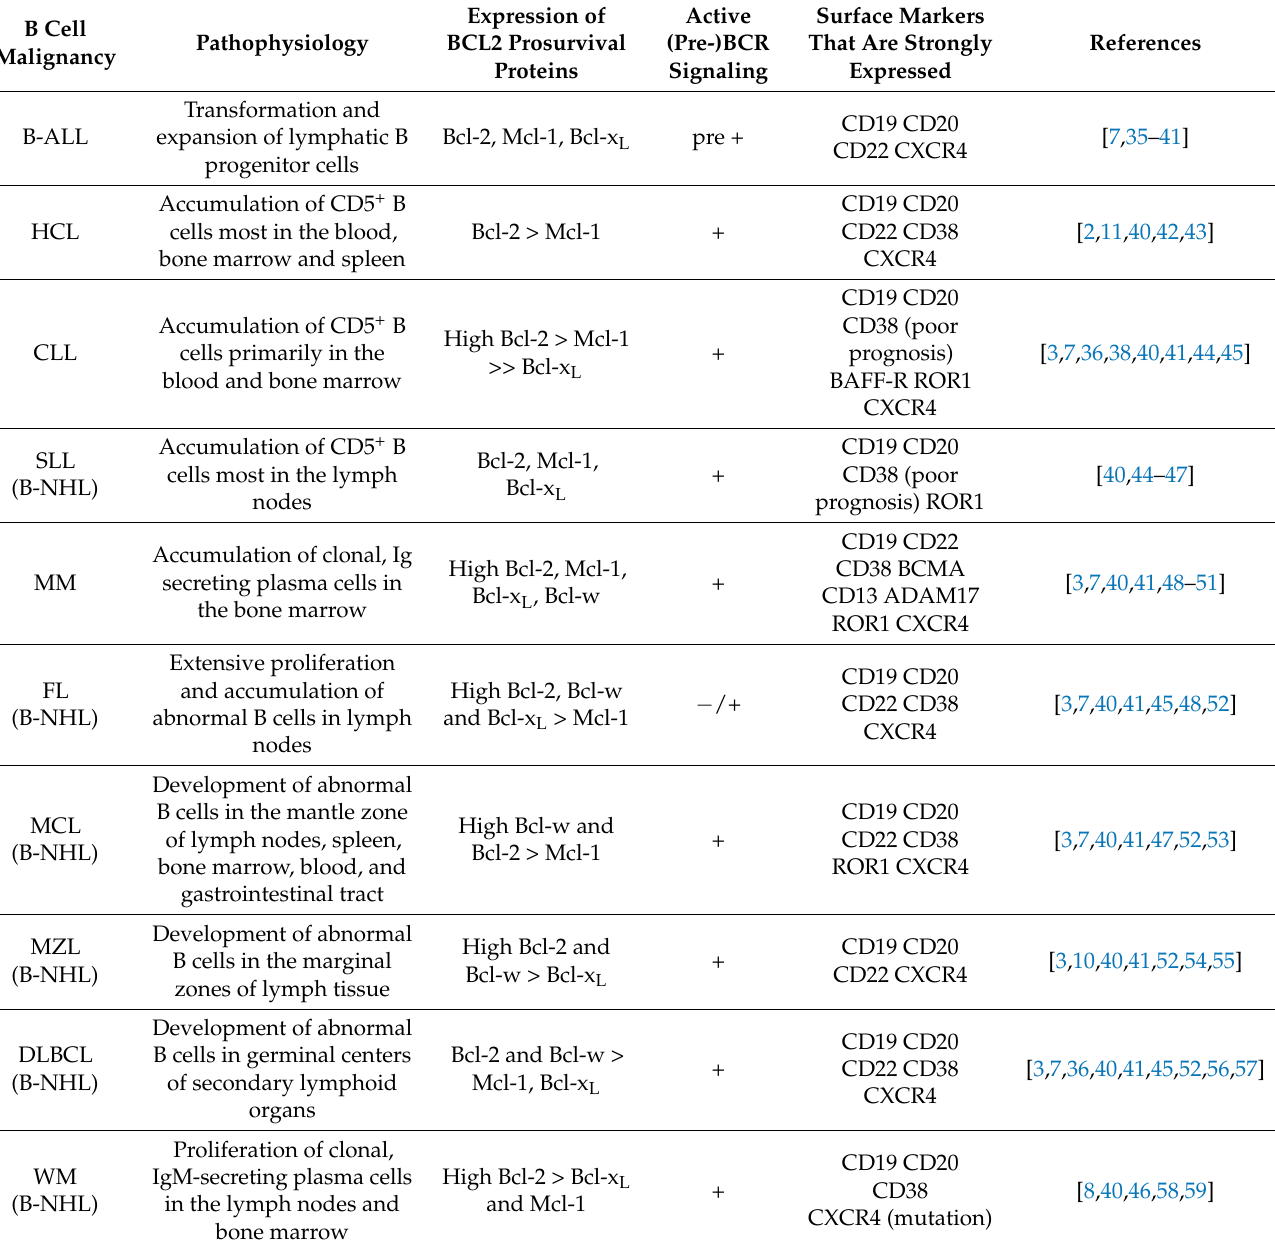
Table 1. Characteristics of the main B cell